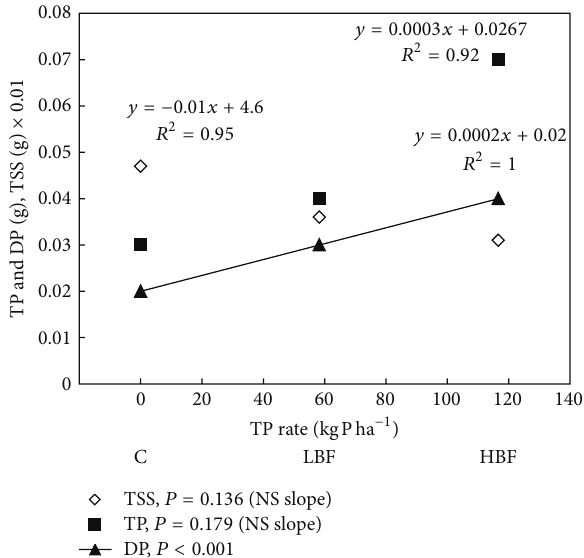
Figure 2: Total suspended solids (TSS), total phosphorus (TP), and dissolved phosphorus (DP) loading in response to TP application rate for C, LBF, and